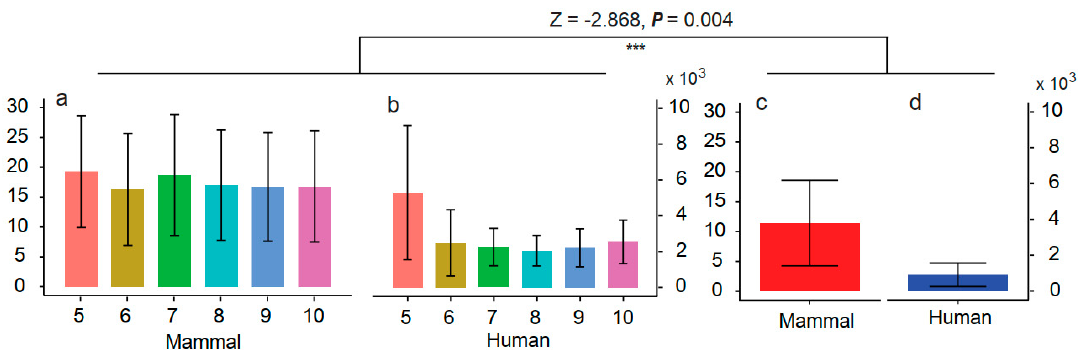
Figure 4. The comparison of R values before and after screening the reads based on deamination-induced C-to-T and/or G-to-A change at ends of DNA fragments. The numbers 5 to 10 on the x -axis denote the first and last X bases for screening the reads with C-to-T and/or G-to-A changes. ( a ) and ( b ) show the average R values of 12 samples after screening, and ( c ) and ( d ) show the average R values of 12 samples before the deamination-based screening. The BLAST search and whole mtDNA database were used in this comparison. The error bars denote the standard error.